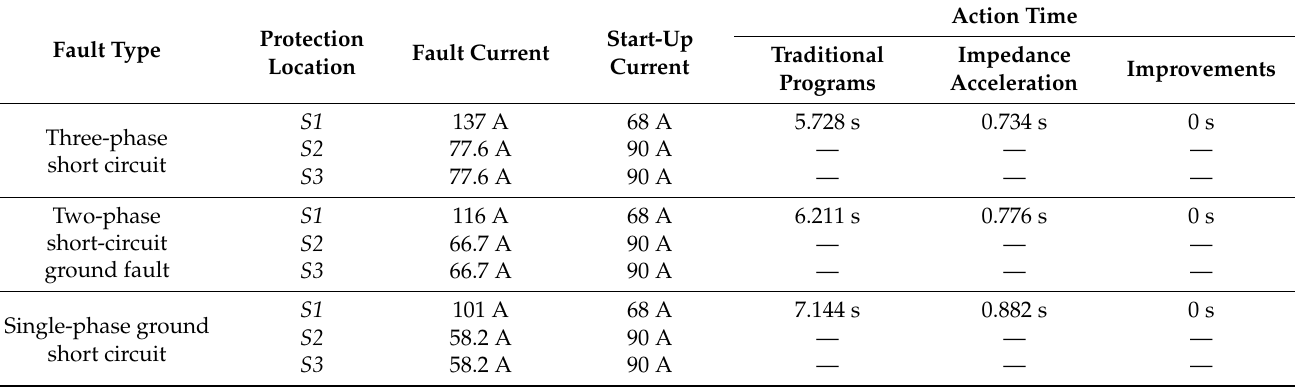
Table 11. Operating time of different protection schemes in the case of line AB via 100 Ω ground resistance